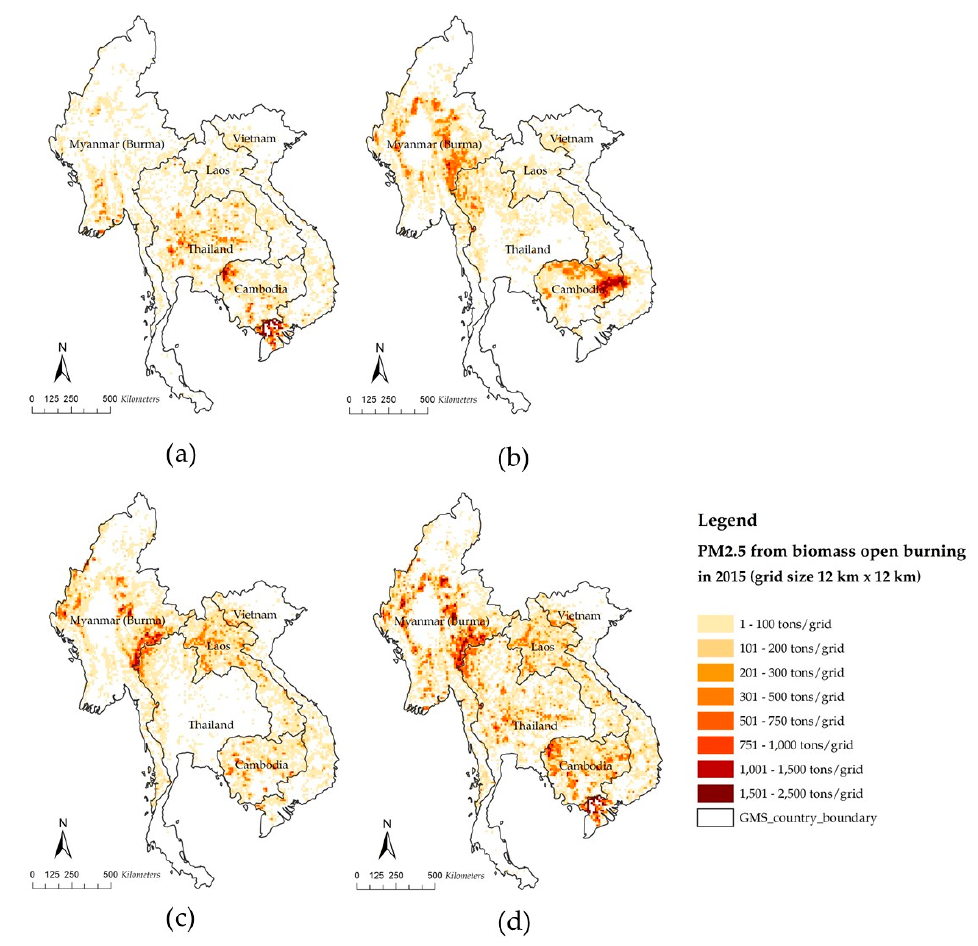
Figure 6. Spatial distribution of the gridded PM2.5 emissions from ( a ) agricultural fires, ( b ) savannah, grassland, and shrubland fires, ( c ) forest fires, and ( d ) biomass open burning in the GMS in 2015; grid size = 12 km × 12 km. Table 7. Comparison of the PM2.5 emissions between this study and the GFED4.1s. PM2.5 Derived from PM2.5 Derived from GFED4.1s (kt) 1 Ratio (This Study / GFED4.1s) This Study (kt) 1 Country